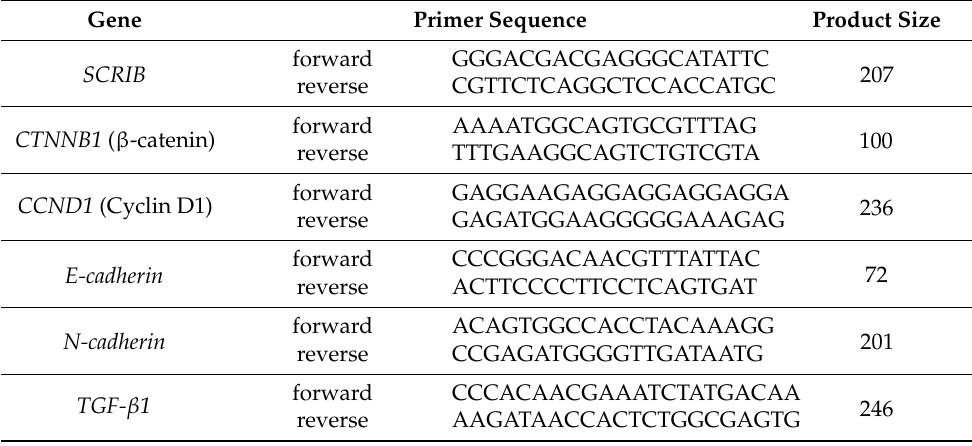
Table 1. Primer sequences used for a